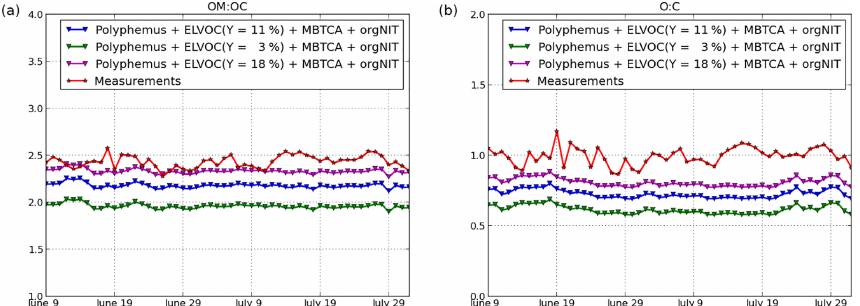
Figure D3. Comparisons of the OM / OC ratio (a) and the O / C ratio (b) for simulations using an ELVOC molar yield of 3, 11 and 18%.